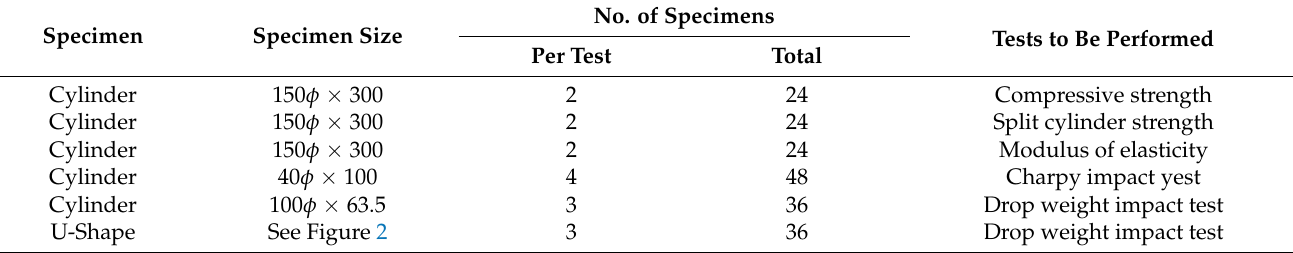
Table 5. Test specimen